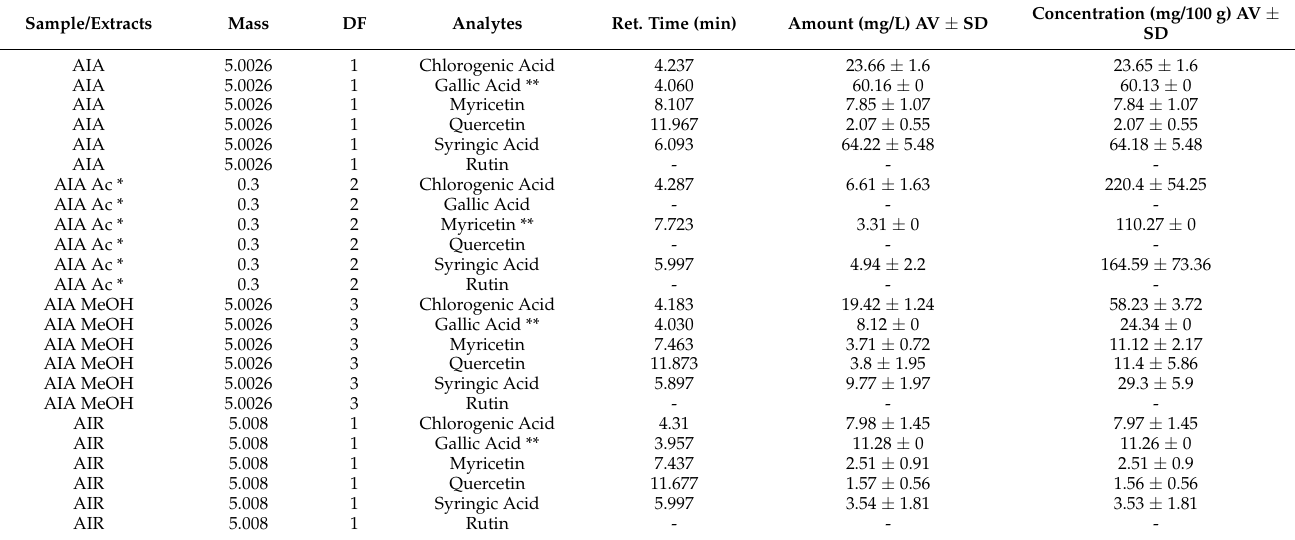
Table 4. Measurement of the zone of inhibition (mm) of test bacteria.